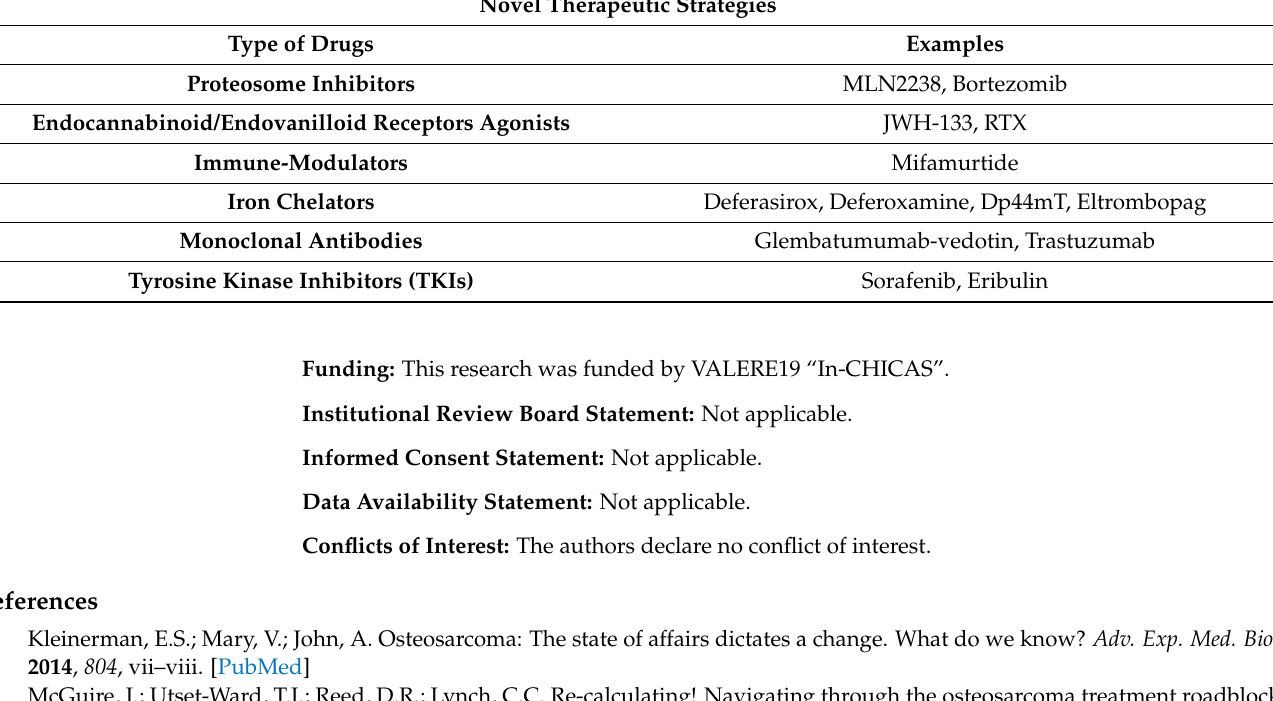
Table 1. The table reported the Novel Therapeutic Strategies discussed. Novel Therapeutic